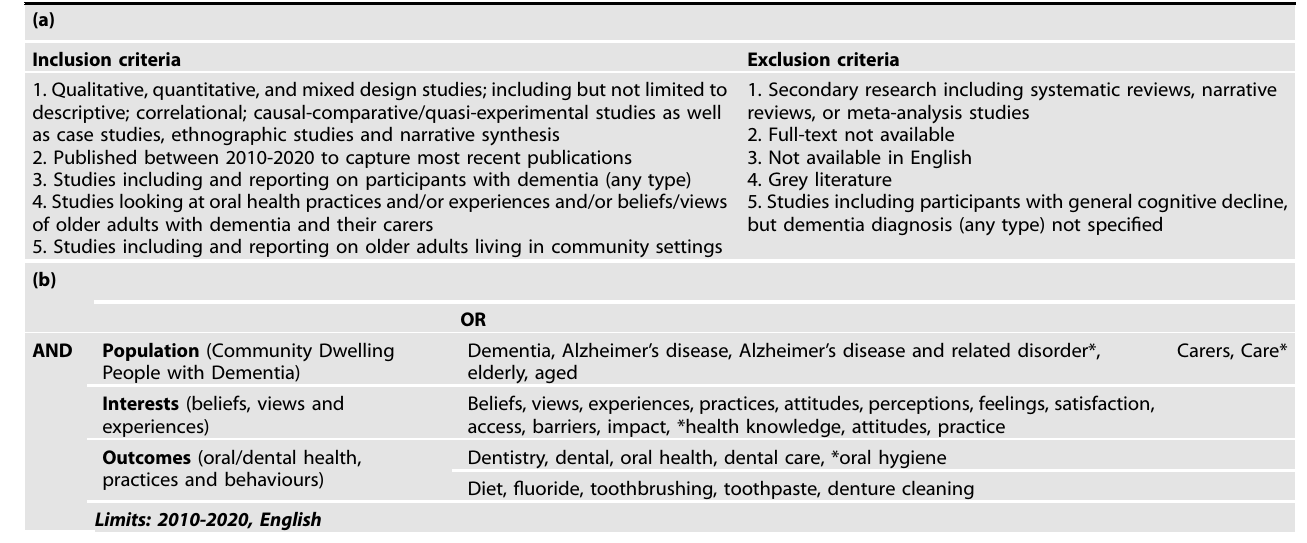
Table 1. a Study inclusion and exclusion criteria. b Search term and strategy outlined using PICO